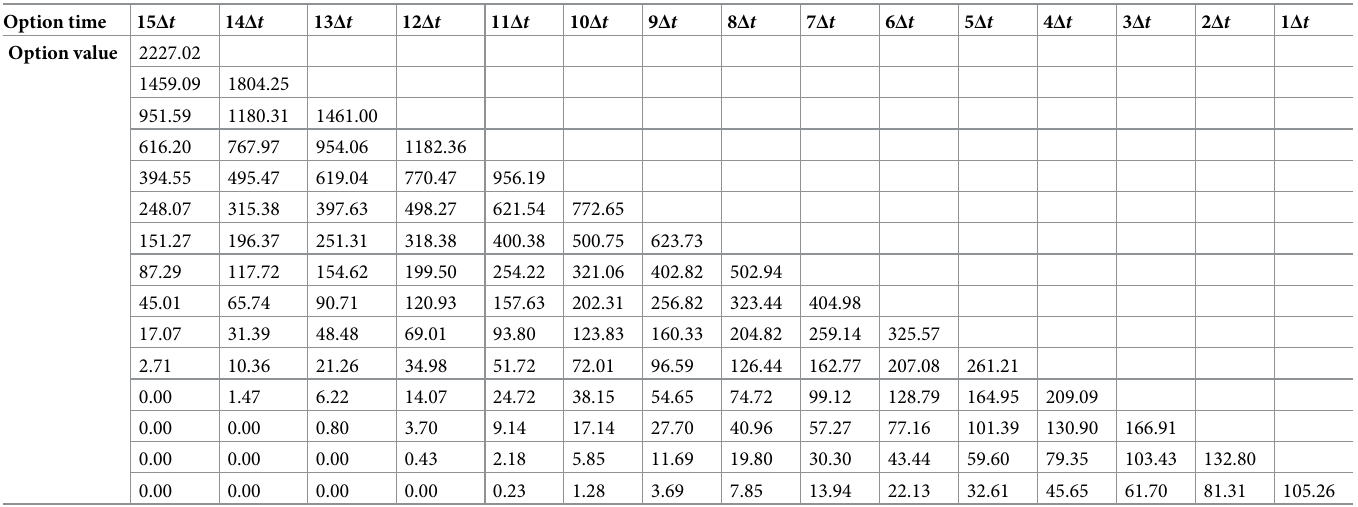
Table 6. Option value calculation